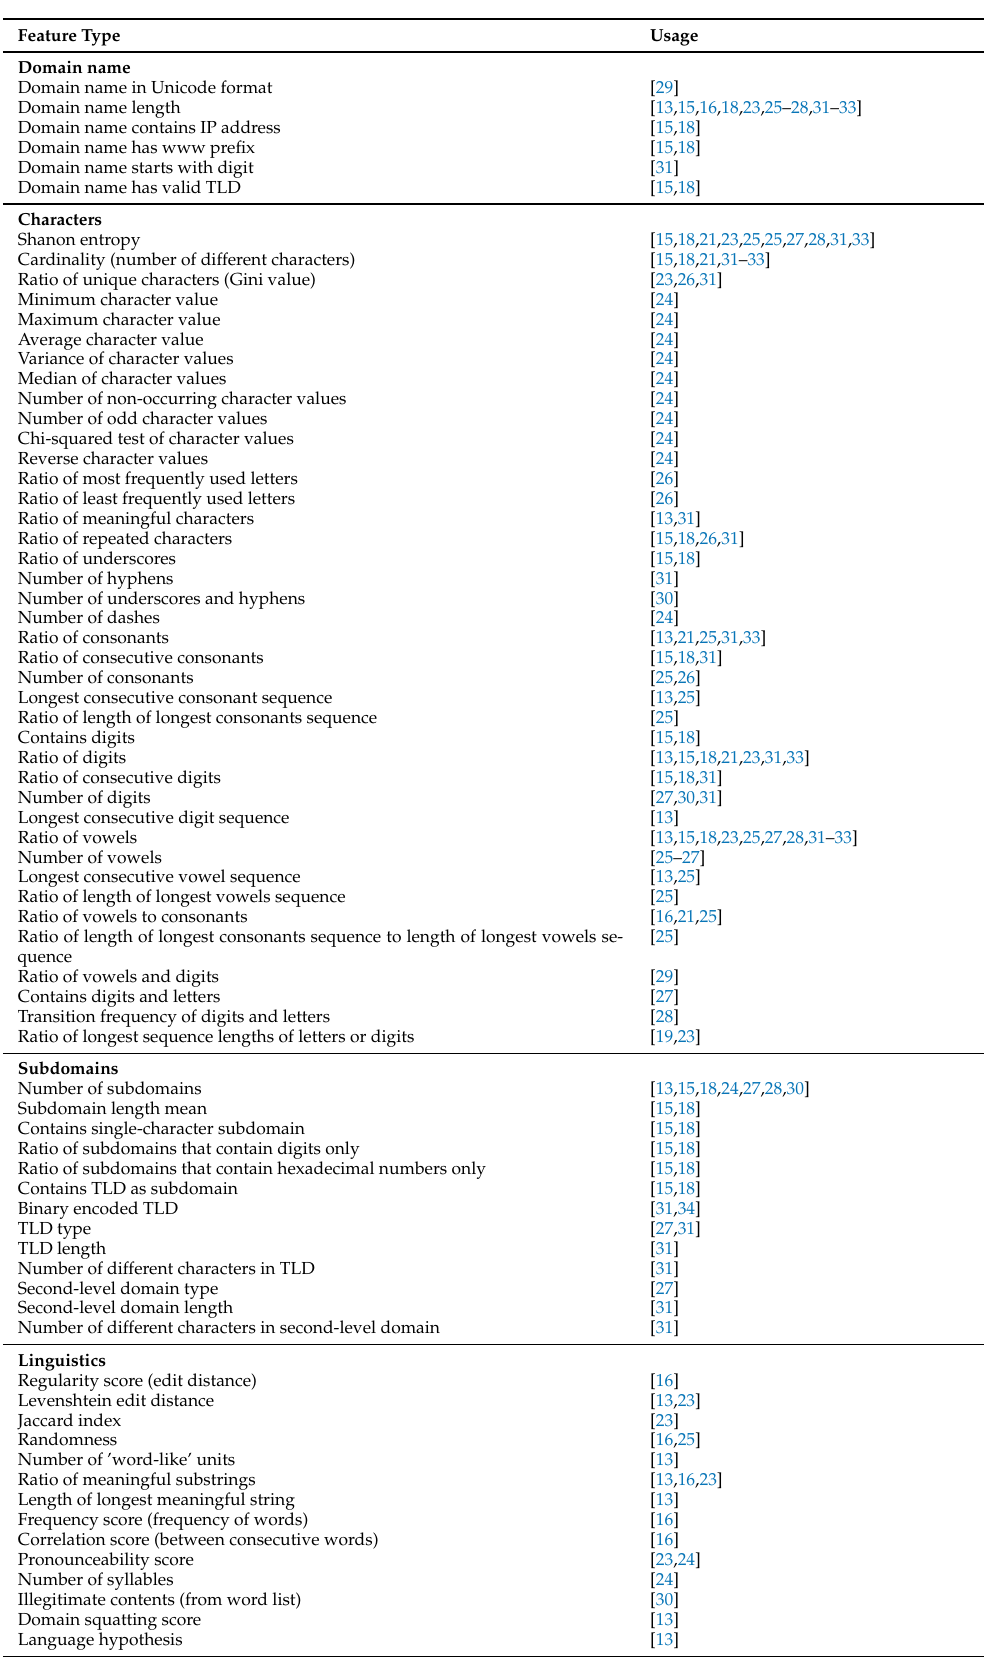
Table 4. Context-free